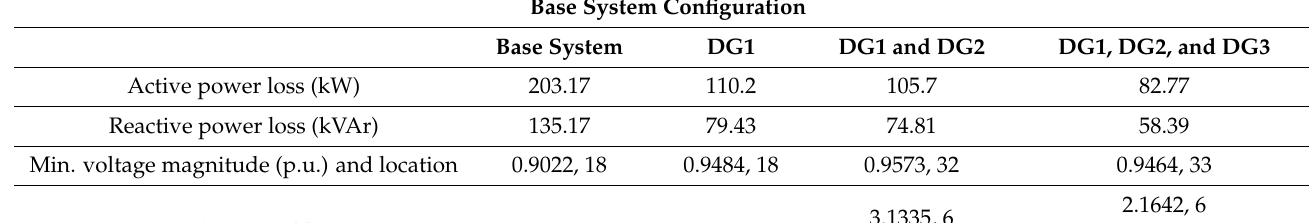
Table 1. Effects of DG units placement on power loss minimization and voltage profile enhancement.